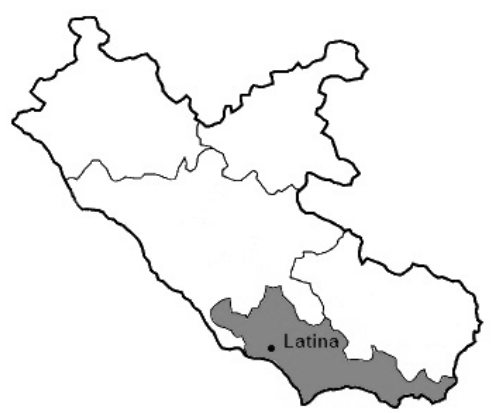
Figure 3. Map of Lazio region (Italy): the area of Latina district is highlighted.